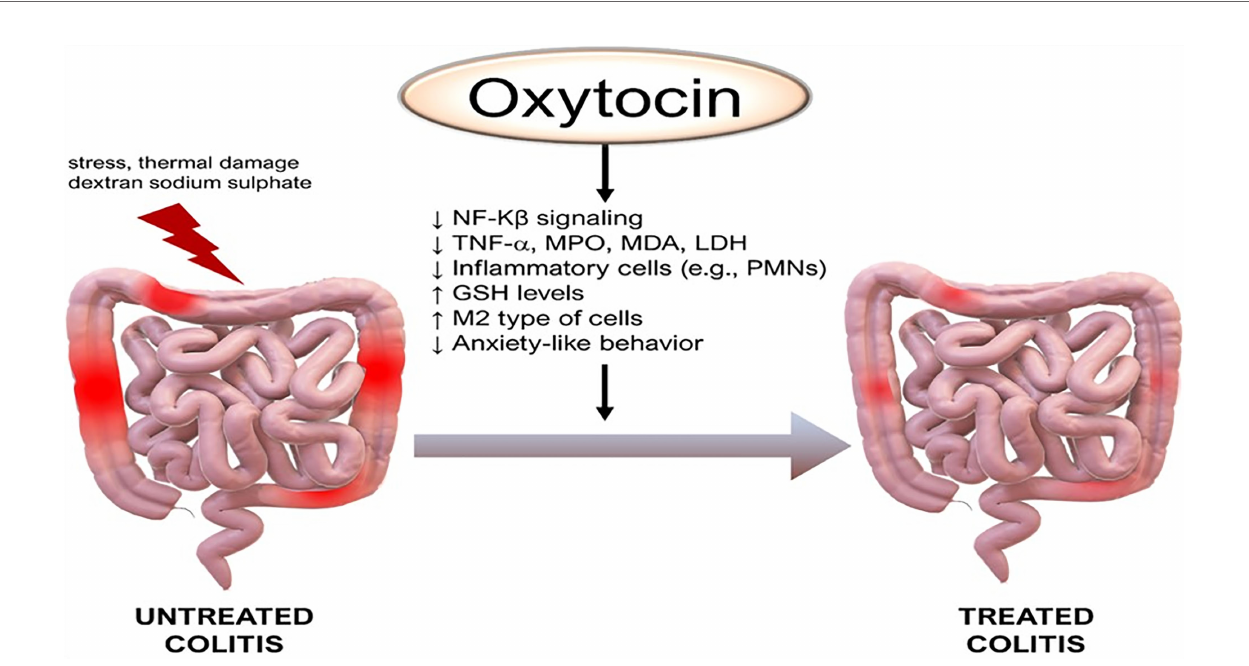
FIGURE 4 | Anti-in fl ammatory effects of oxytocin on the colon. Of note, M2 are anti-in fl ammatory macrophages that contribute to tissue healing. GSH, glutathione; LDH, lactate dehydrogenase; MDA, malondialdehyde, PMNs, polymorphonuclear leukocytes. Other annotations are the same as Figure 1 . (Original by the authors of the manuscript). Up arrow ( ↑ ) symbol indicates increase, whereas down ( ↓ ) arrow symbol indicates decrease in the effect